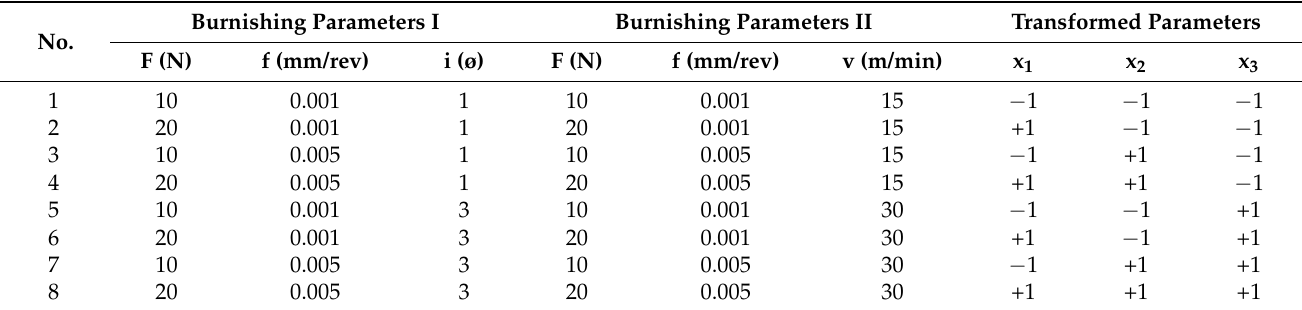
Table 2. Burnishing parameters.